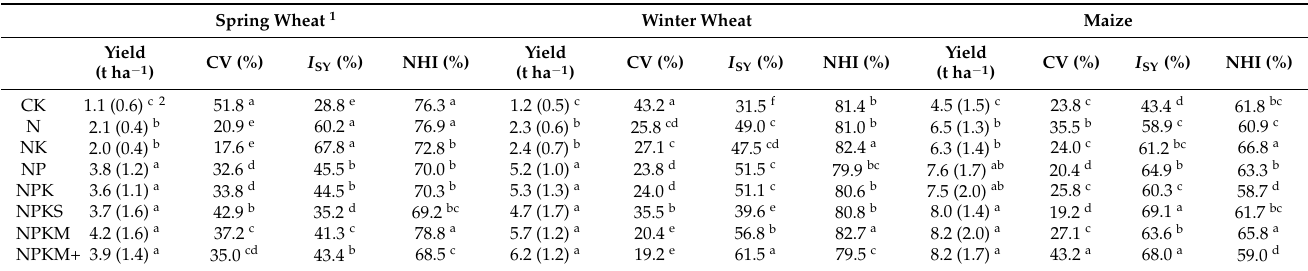
Table 3. Mean yield, coefficient of variation (CV), sustainable yield index ( I sy ), and nitrogen harvest index (NHI) of spring wheat, winter wheat, and maize and the ANOVA results showing ‘Groups’ of treatments from 24 years’ data.